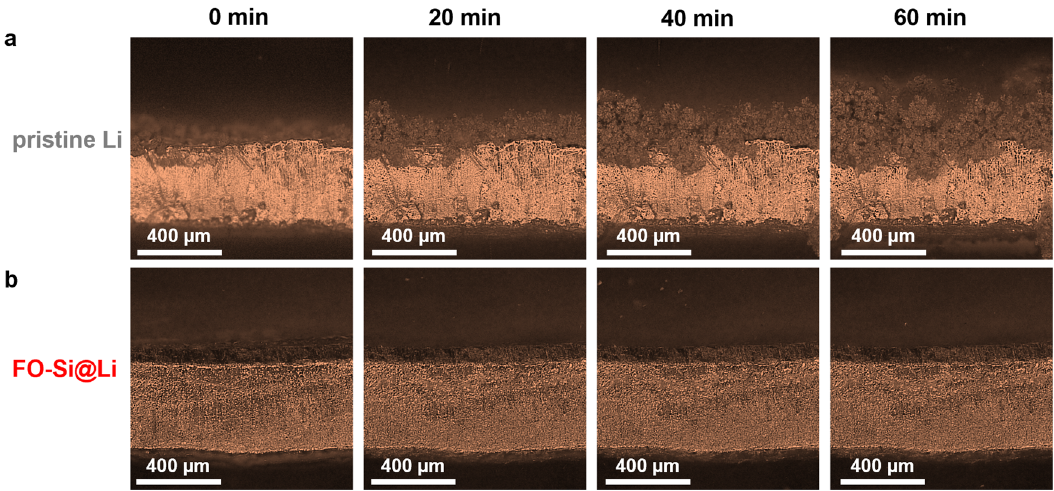
Fig. 4 In operando observation of Li deposition. In operando optical microscopy images of Li deposits on a pristine Li and b FO – Si@Li upon plating time at a current density of 1 mA cm − 2